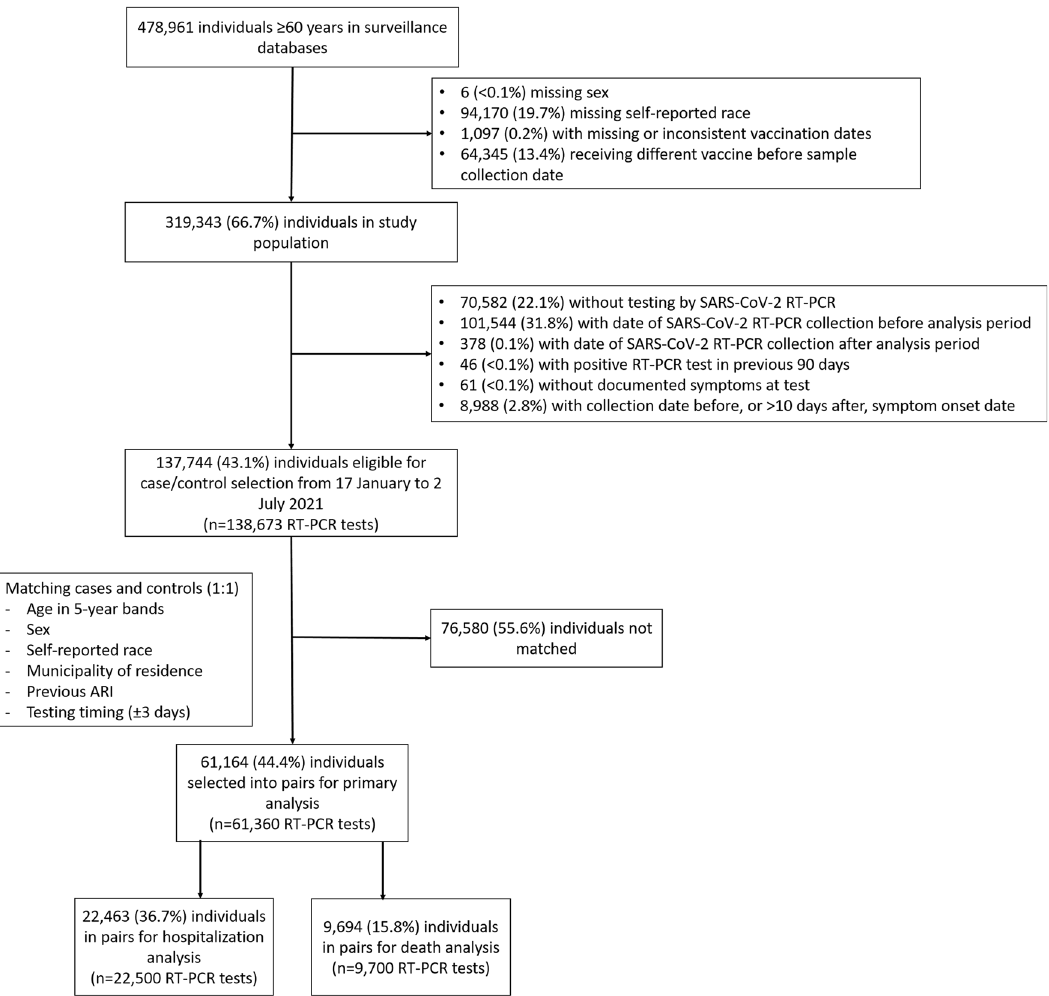
Fig. 2 Study fl owchart. Flowchart of the identi fi cation of the study population from surveillance databases and selection of matched cases and